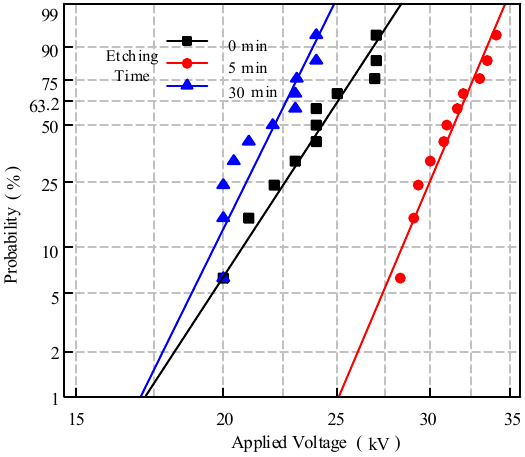
Figure 7. Weibull plots of DC surface flashover of samples with different etching times.